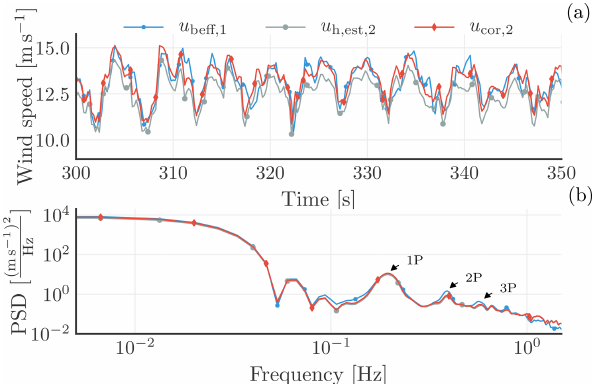
Figure 10. Identified DC gain upper ( G n ,k + w (cid:96),k ) and lower ( G n ,k ) bounds of the transfer functions ( G (cid:96),k ) from the blade effective wind speeds ( u beff ,k ) to the corrected lidar-based inflow wind speeds ( u cor ,k ), with k ∈ { col, yaw, tilt } ; C 1 – C 5 represent the in- vestigated cases (outlined in Table 1).